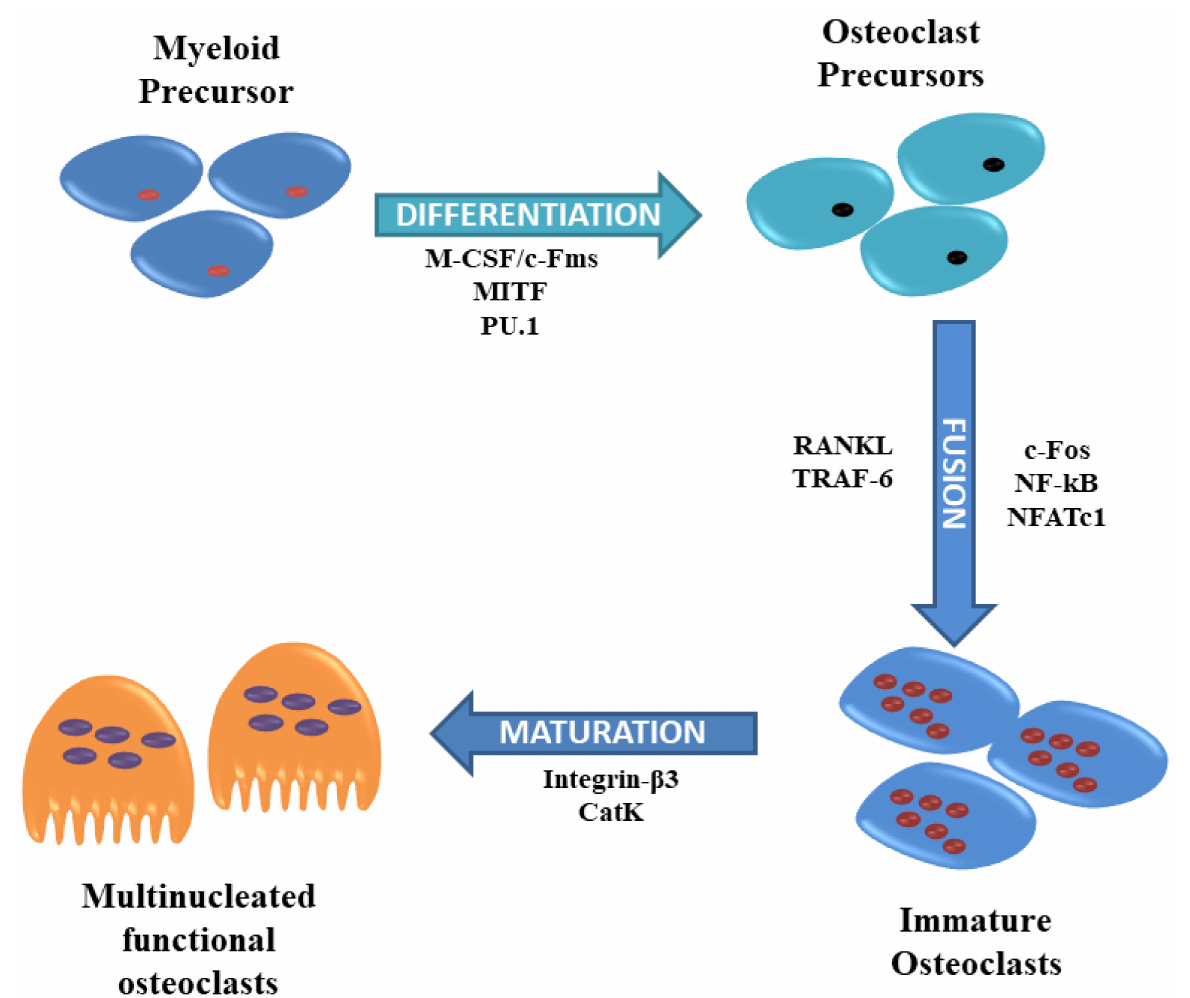
Figure 3. Molecules involved in the process of osteoclast differentiation. M-CSF/c-Fms, MITF, and PU.1 promote differenti- ation of myeloid precursors into osteoclasts precursor which fuse together to form immature osteoclasts. The maturation of immature osteoclasts to mature osteoclasts is facilitated by integrin- β 3 and